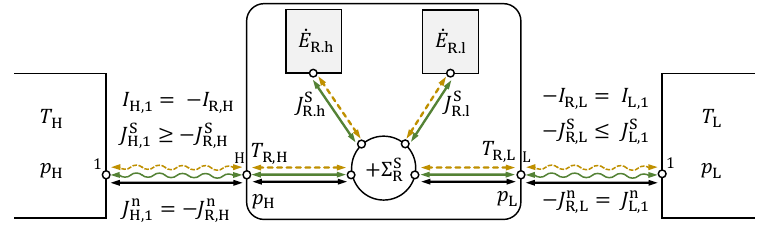
Figure 10. Schematics of the EE -regenerator composed of an engine and two internal heat reservoirs. The two internal heat reservoir’s energies E R.h and E R.l can change independently according to Equations (40)–(42) so that the energy and entropy balances of the regenerator are fulfilled. The temperatures at the regenerator’s contact points H and L are determined by the current values of E E ES -regenerator model, this internal R.h and R.l via Equations (38) and (39). As opposed to the endoreversible structure brings about the possibility to consider temperature gradient evolutions with sign